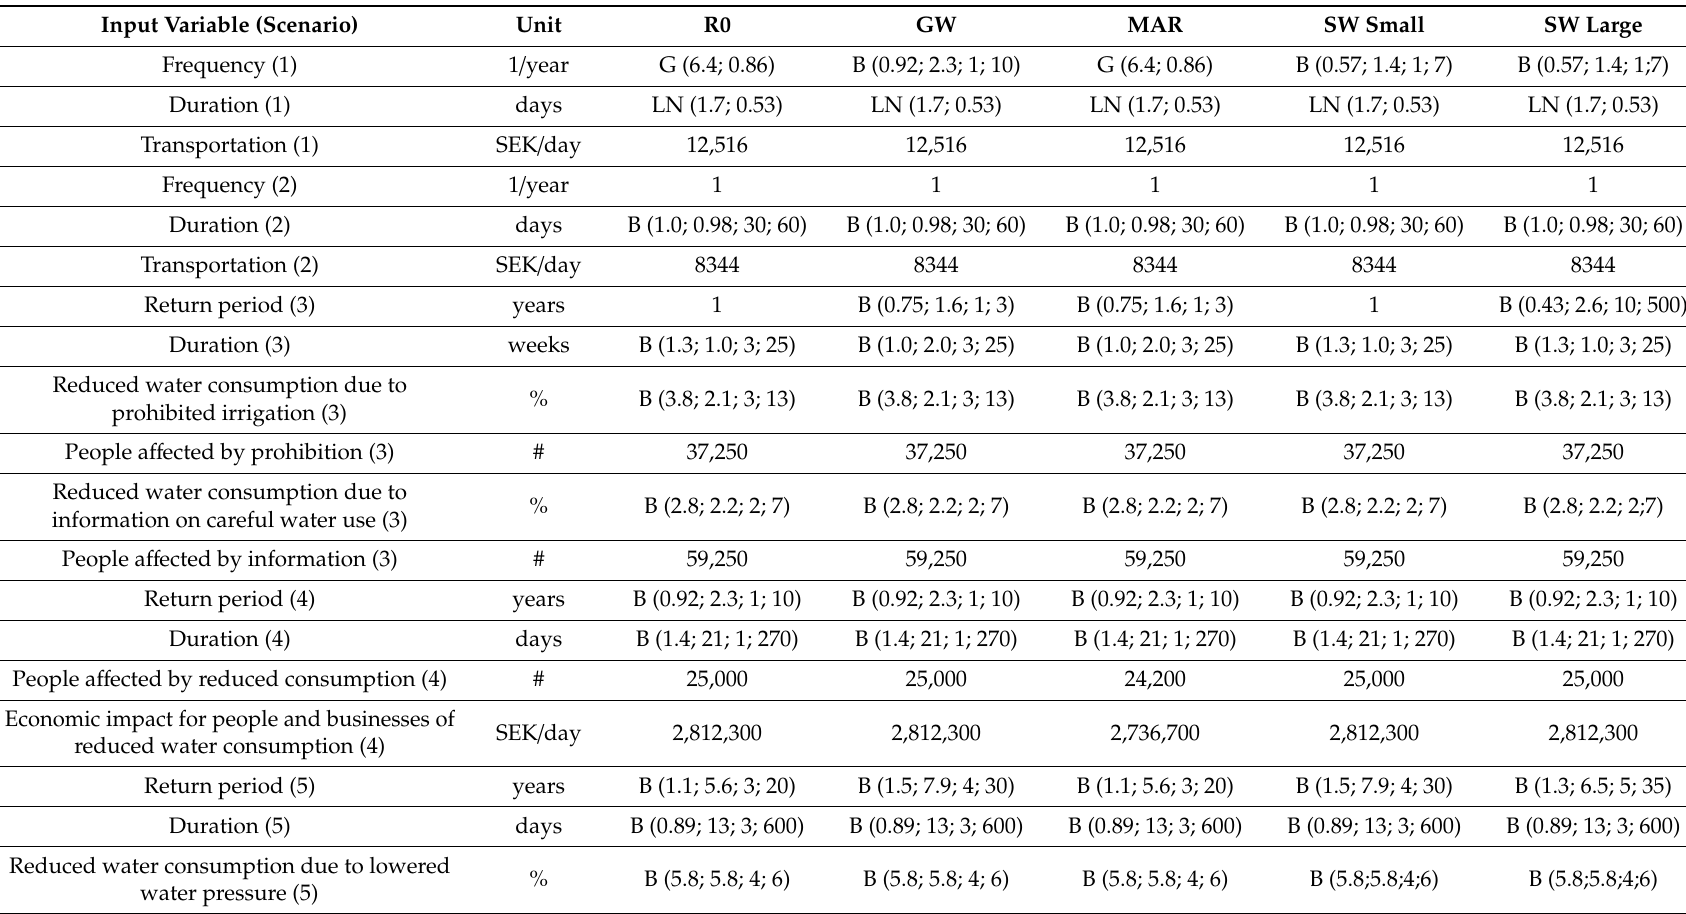
Table 3. Estimates of input variables. Distributions used are log-normal, LN ( µ ; σ ), beta, B ( α 1; α 2; min; max) and gamma, G ( α ; β ). R0 = reference alternative; GW = groundwater extraction; MAR = managed aquifer recharge; SW small = surface water extraction small scale; SW large = surface water extraction large